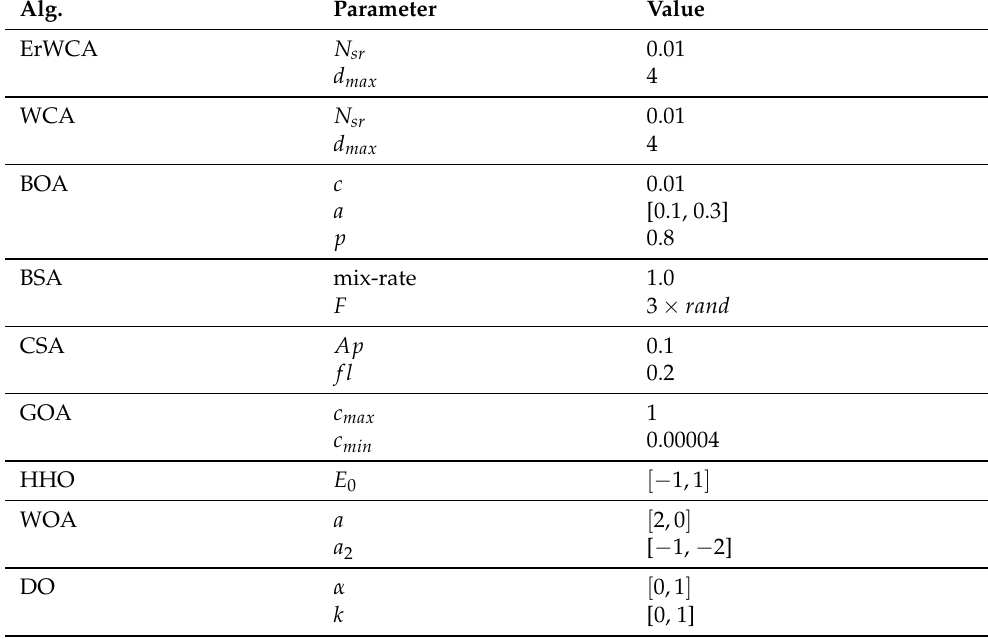
Table 2. Meta-heuristic algorithms parameter settings.